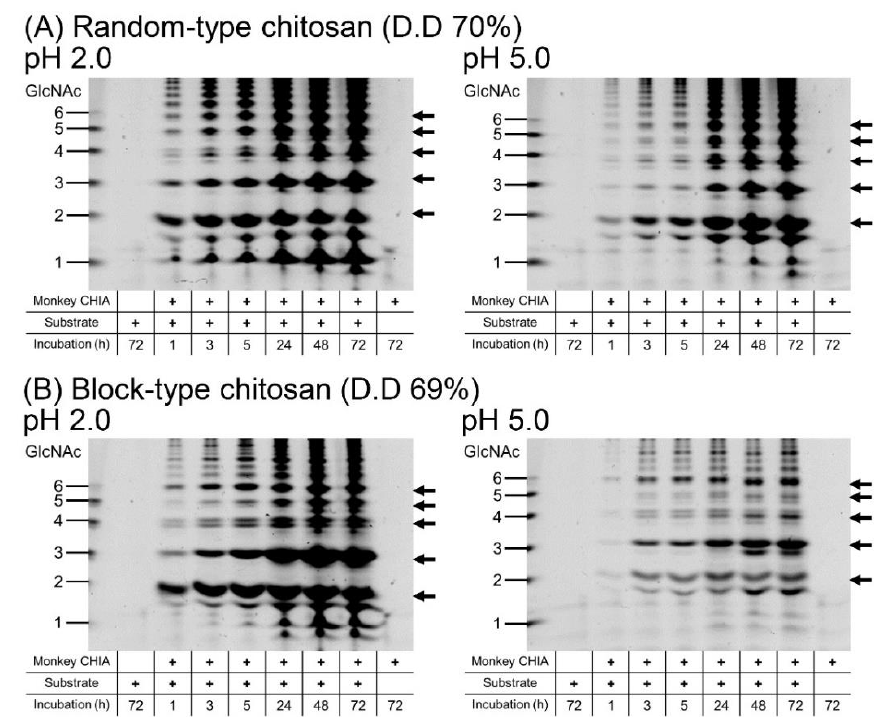
Figure 3. FACE analysis of chitosan substrate degradation by monkey CHIA. The substrates, random-type ( A ) and block-type chitosan ( B ) were incubated with monkey CHIA at pH 2.0 or 5.0 and 50 ◦ C for 1, 3, 5, 24, 48, and 72 h. Left panels show results of the reactions at pH 2.0; right panels show results of the reactions at pH 5.0. Full-length gel images are shown in Supplementary Figure S7. Size standards on the left margin are defined as chitin oligomers.